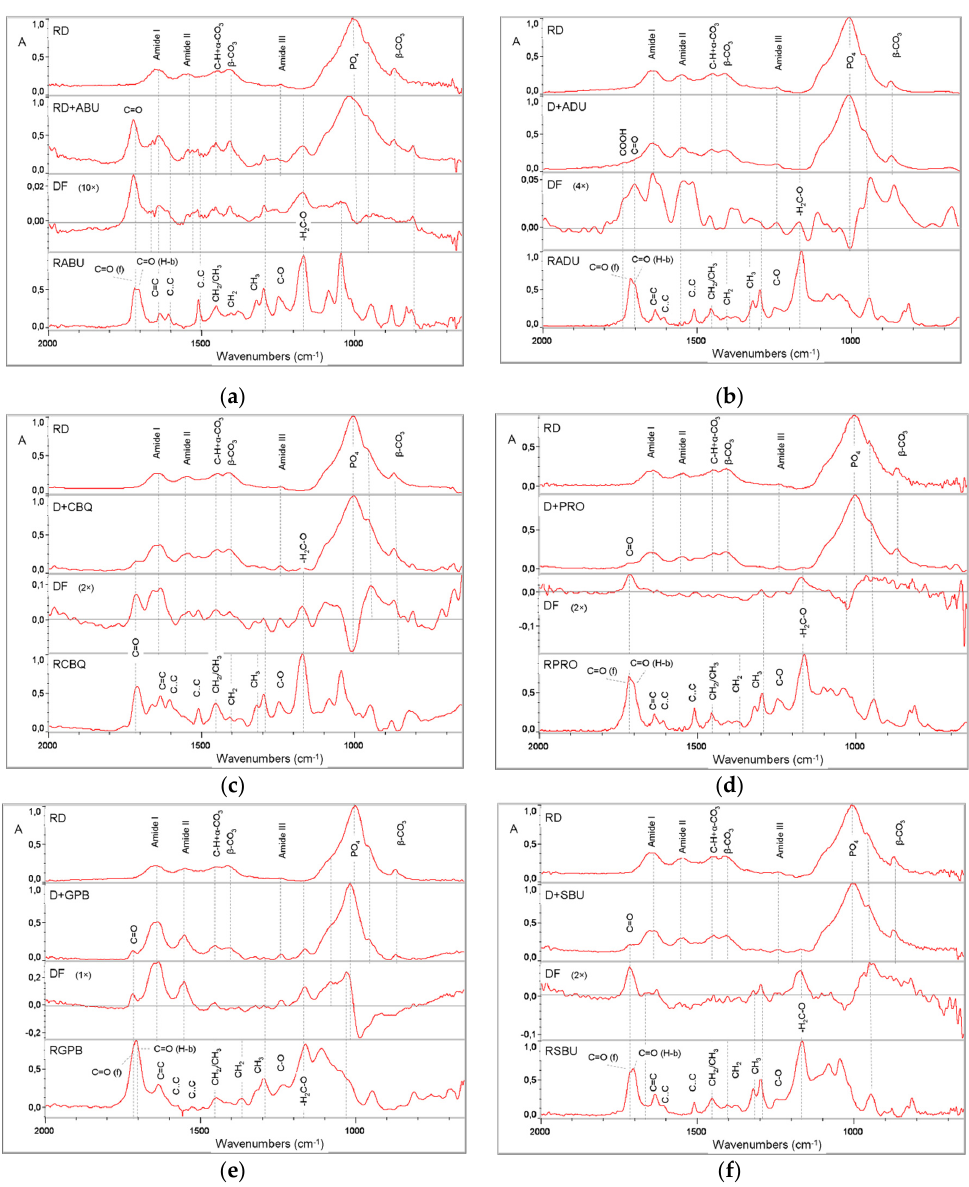
Figure 3. Representative reflection Fourier transform infrared microscopy (RFTIRM) spectra of reference dentin (RD), of dentin treated with the adhesives plus rinsing (RD + adhesive code), the difference spectra (DF, treated dentin-reference dentin) and the transmission spectra (RF + adhesive code) of reference adhesives after solvent evaporation (absorbance scale, 2000–750 cm − 1 wavenumber